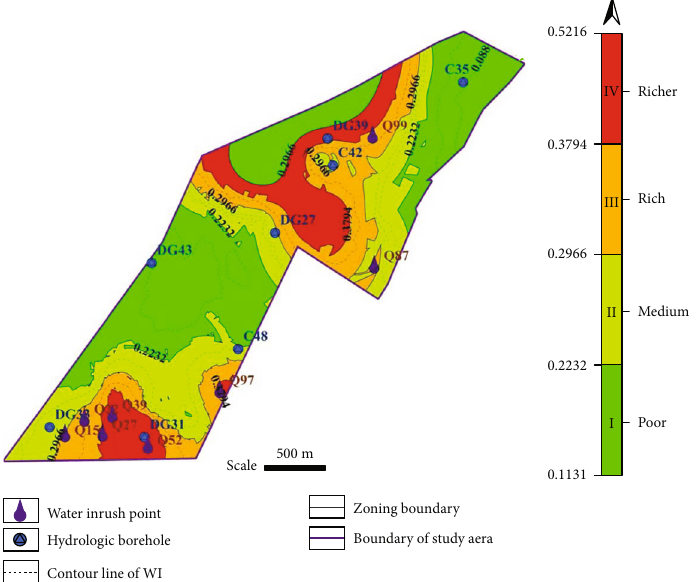
Figure 8: Water yield zoning map based on the WYPI model weighted by the